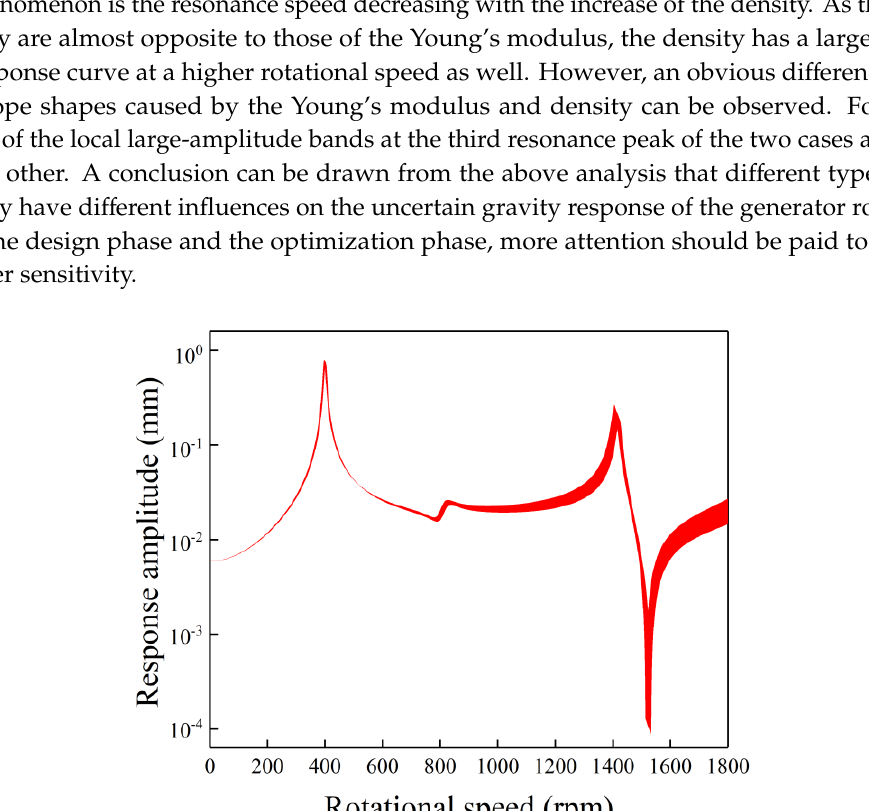
Figure 6. The bounds of uncertain gravity response versus rotational speed by the CIM with a 5% deviation in Young’s modulus.